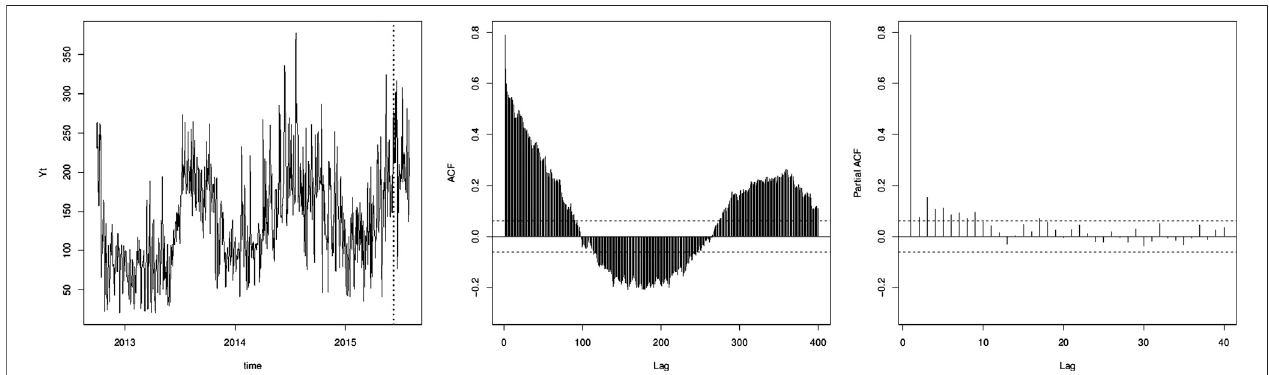
FIGURE1|(Left) Data,meandailyradonobservations in Bq / m 3 at Pietralunga (Umbria, Italy). Thered vertical lineseparatesthe trainingset and theremaining 5% of the test set. (Central) Autocorrelation coef fi cient and (right) partial autocorrelation coef fi cient of the time series.